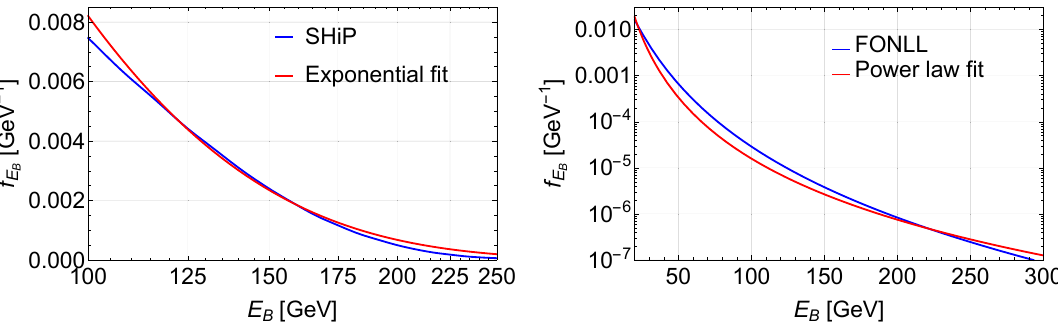
Figure 18 . Fits of the high energy tail of the distributions of the B mesons. Left panel: SHiP data is taken from [64]. Right panel: the FONLL simulations are performed for √ s = 13 TeV and η | | ∼